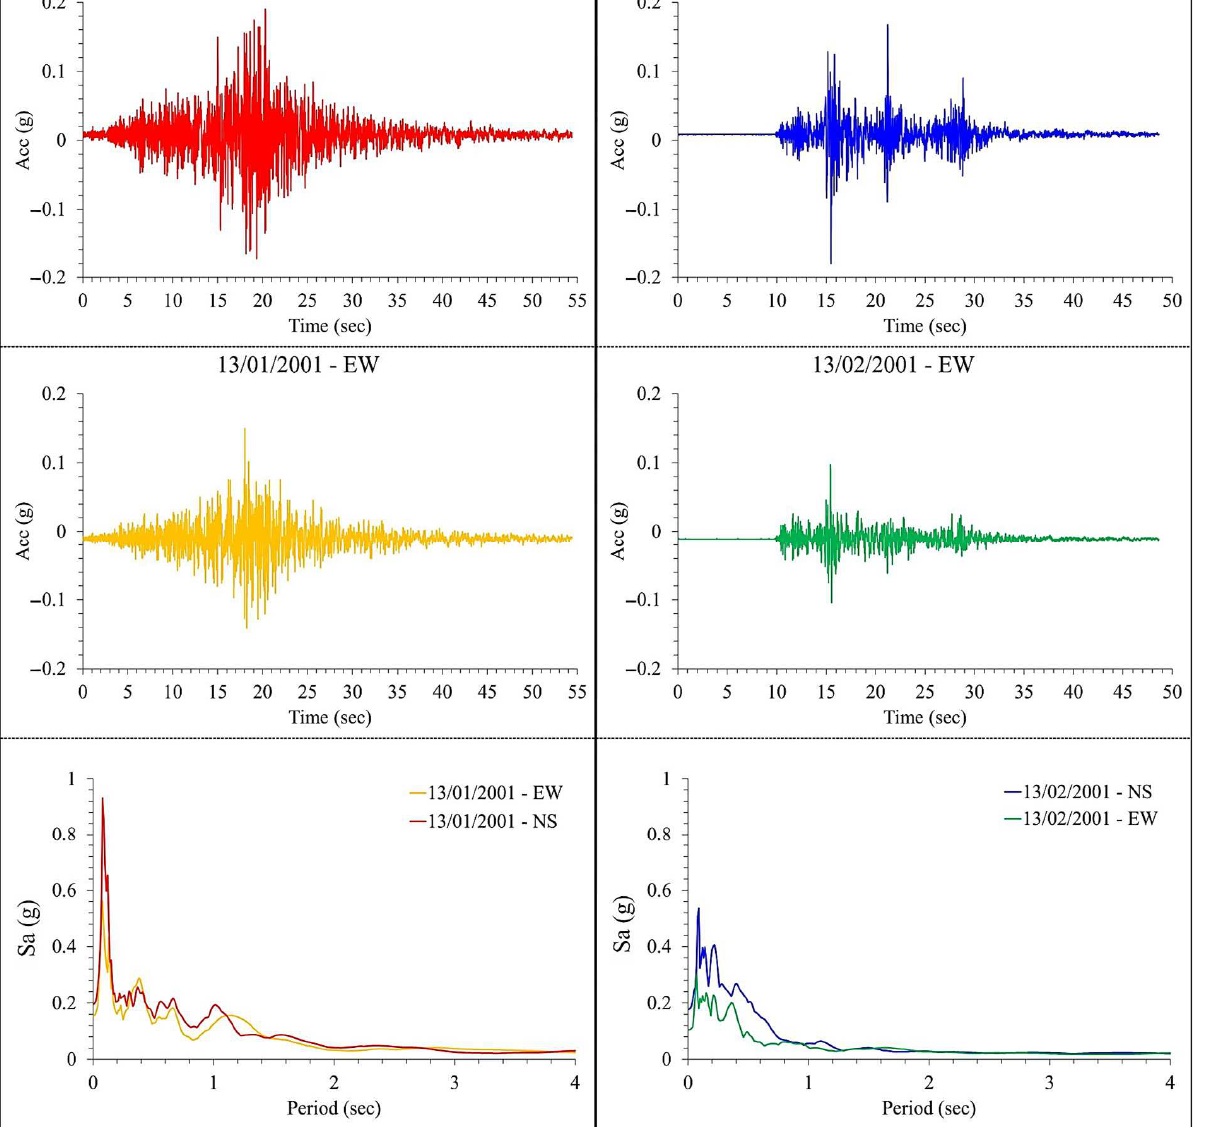
Figure 10. Time histories and response spectra of four accelerograms used as input motion for 2D numerical simulations.